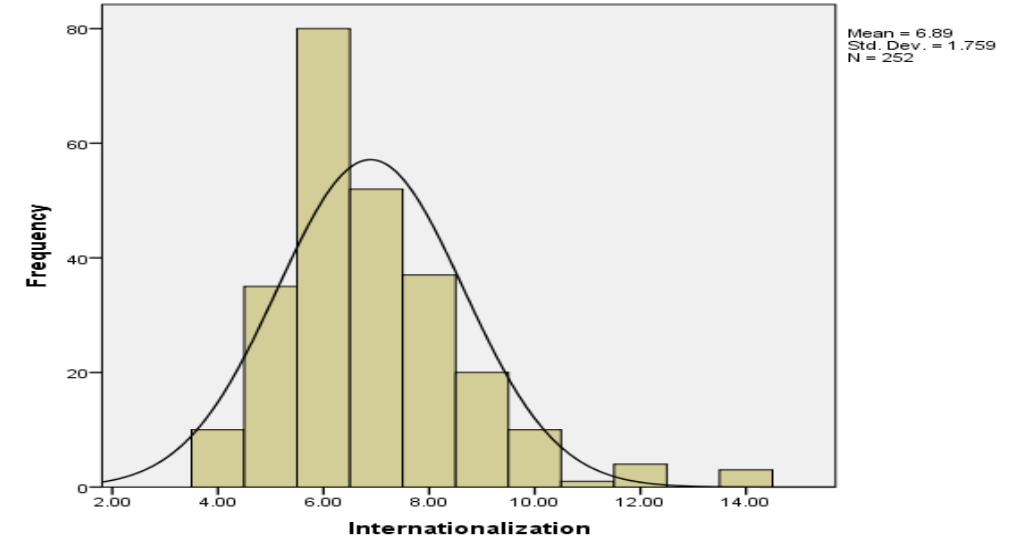
Fig . 1 . Histogram of the perceived internationalisation scores (The Author’s Fieldwork Computation, 2019